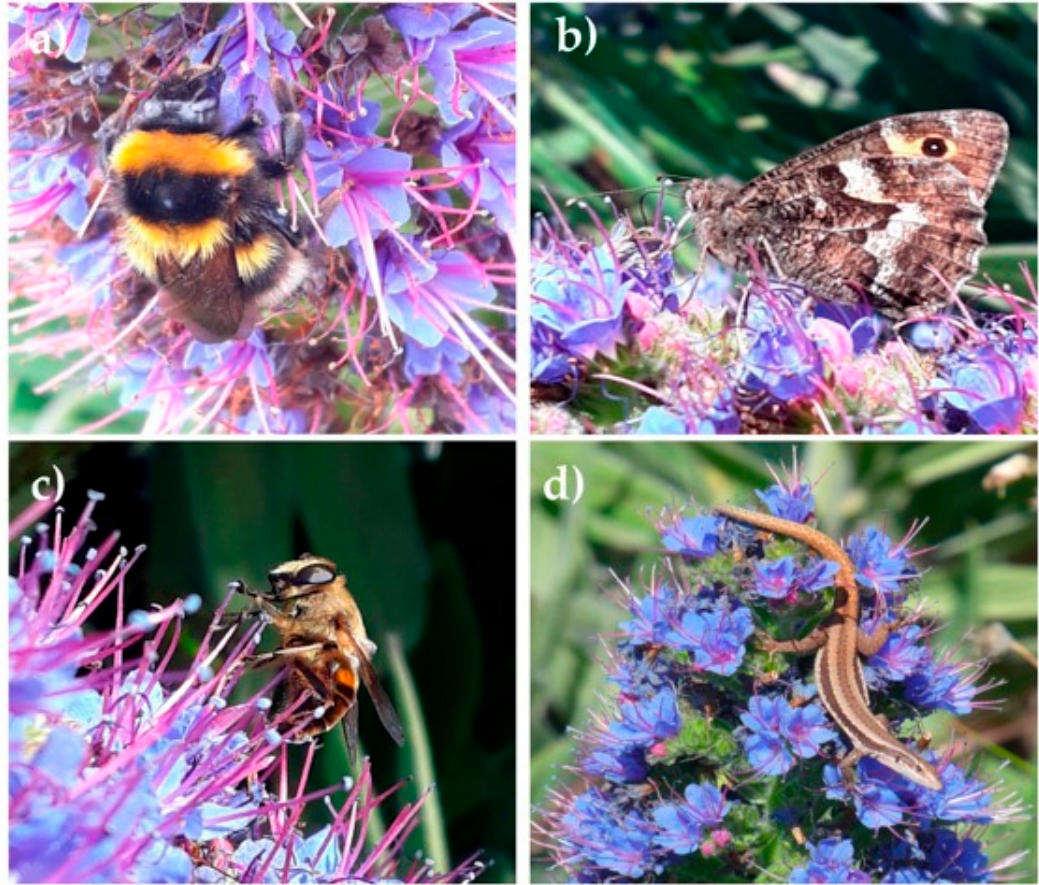
Figure 1. Some frequent flower visitors of Echium candicans at Pico do Arieiro: ( a ) the non-native Bombus ruderatus ; ( b ) the endemic Hipparchia maderensis ; ( c ) the native Eristalis tenax , and ( d ) the endemic lizard Teira dugesii .